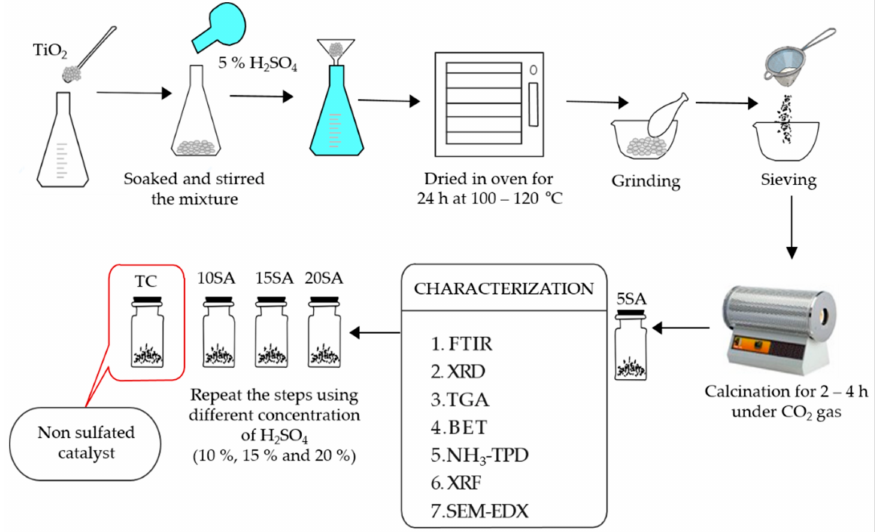
Figure 8. Preparation of non-sulphated and sulphated-titania catalyst at various